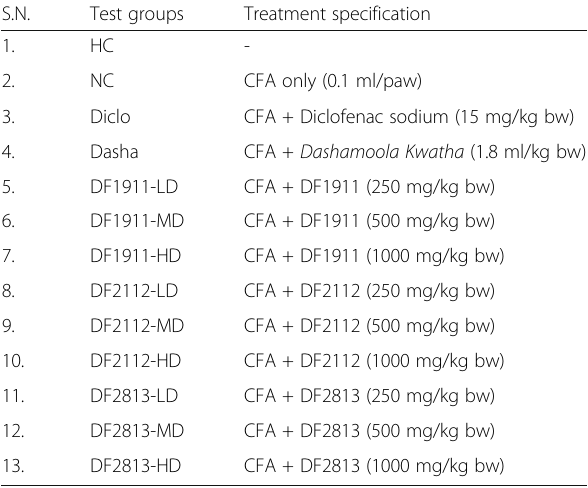
Table 3 Test groups of CFA induced inflammation in rat